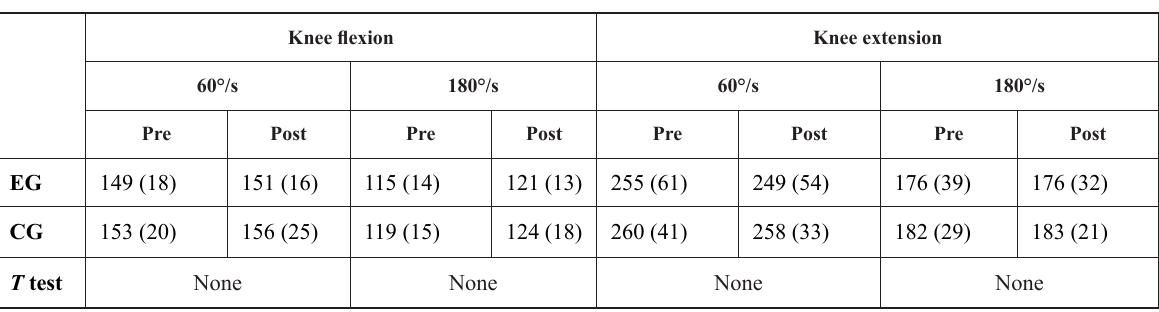
Table. Concentric peak torque (Nm) for knee flexion and knee